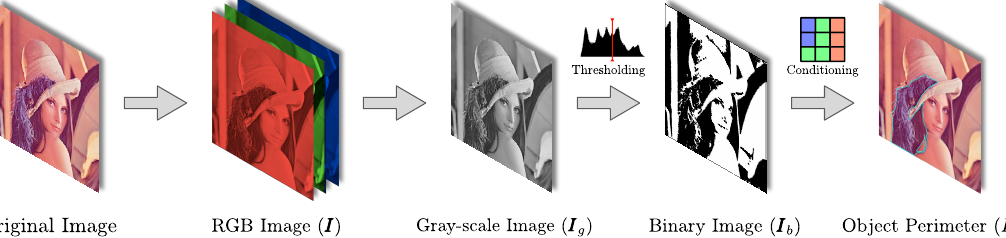
Figure 2. General diagram of image segmentation based on background and